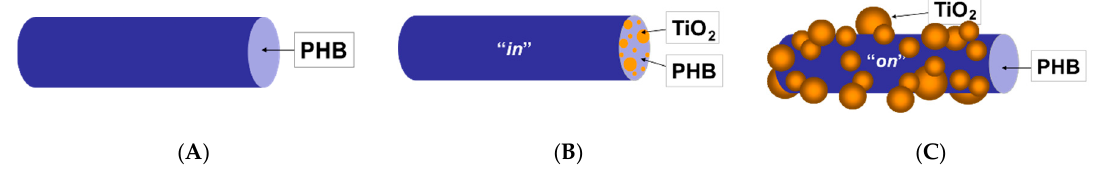
Figure 2. Schematic representation of fibers: ( A ) PHB, ( B ) TiO 2 - in -PHB and ( C ) TiO 2 - on